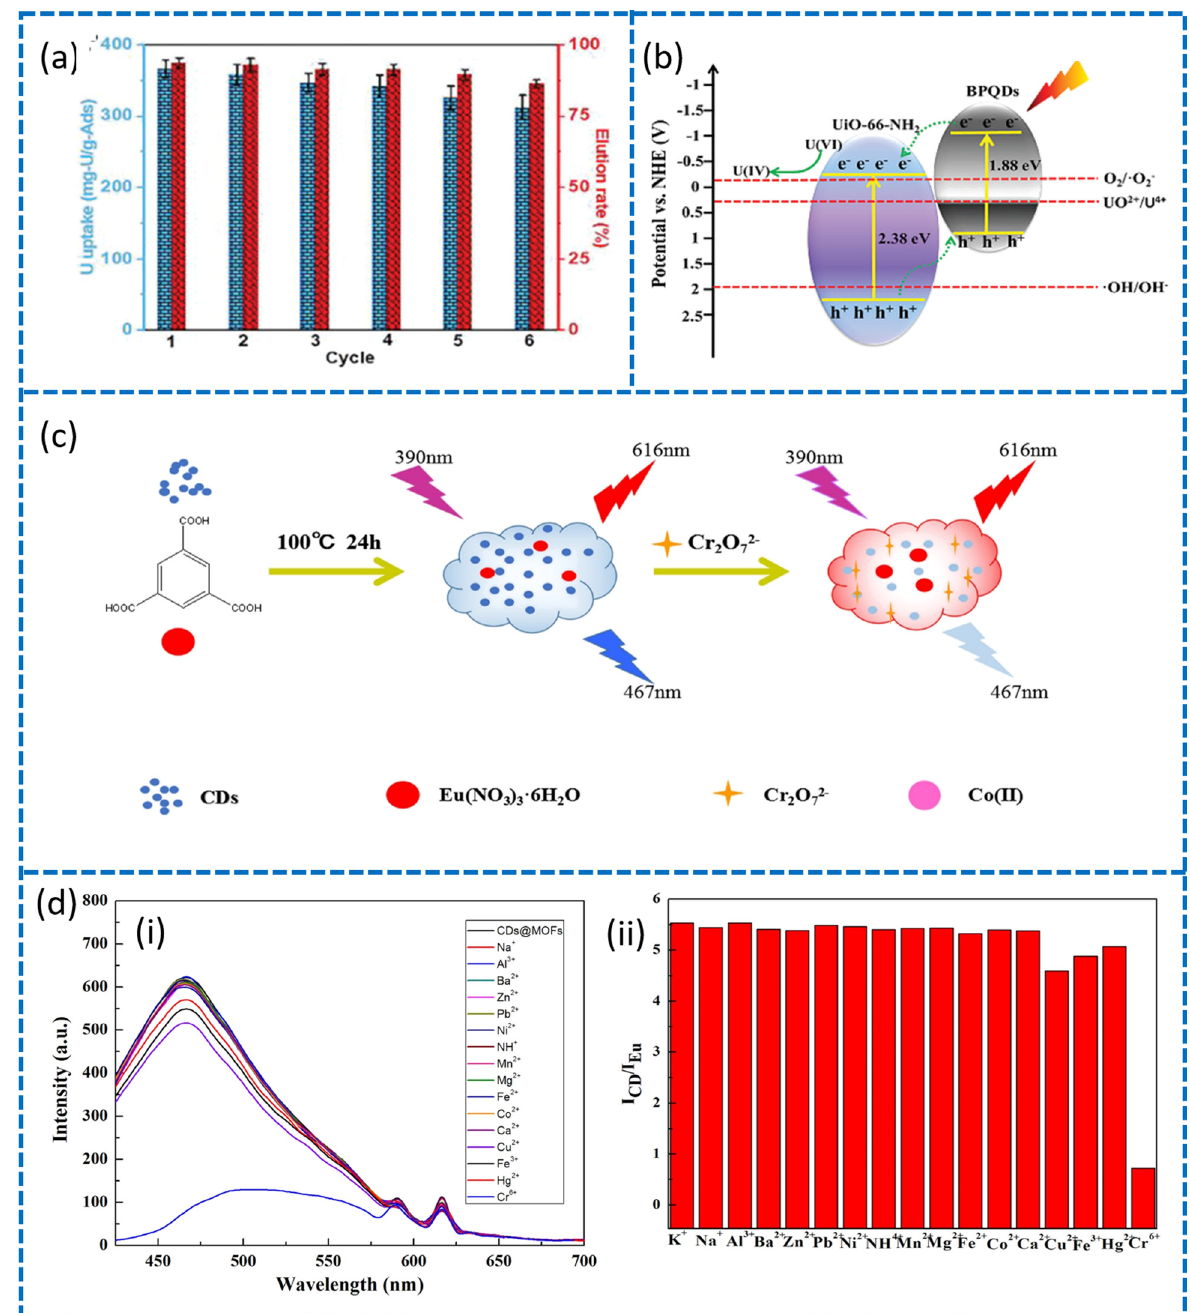
Figure 5: ( a ) Under light irradiation, uranium adsorption capacity and elution e ffi ciency in six consecutive cycles. ( b ) A schematic repre - sentation ofthe photocatalyticreduction ofU ( VI ) utilizing MOF/BPQDshybrid under solar - light irradiation [ 106 ] . ( c ) A schematic representation of the photocatalytic reduction of U ( VI ) utilizing MOF/BPQDs hybrid under solar - light irradiation. ( d ) The CDs@Eu - MOFs fl uorescence selec - tivity spectra in the absence and presence of di ff erent metal ions [ 124 ]